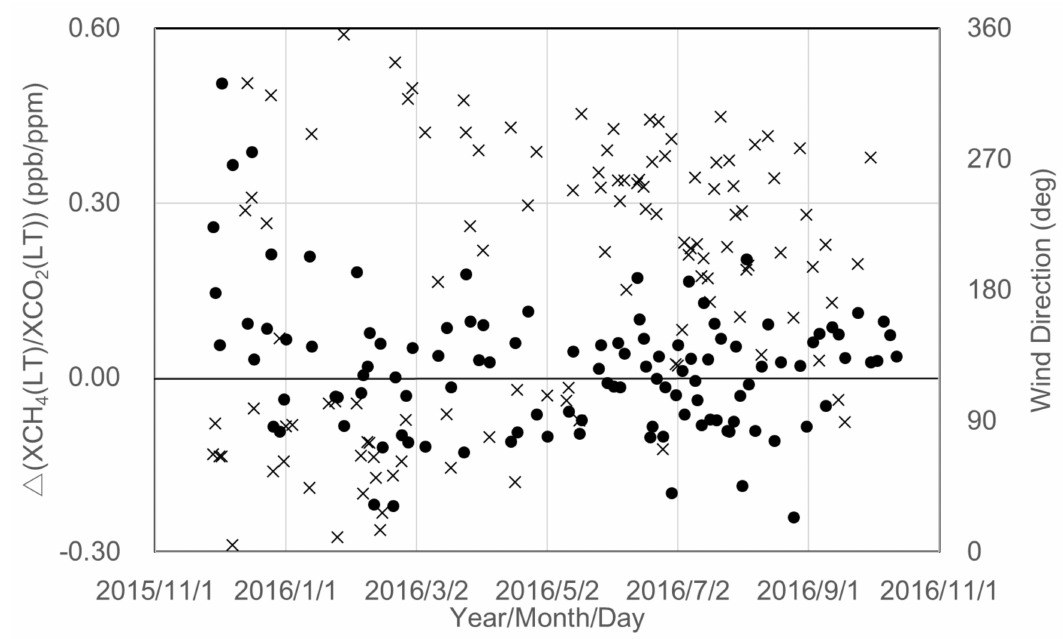
Figure A3. XCH 4 (LT) / XCO 2 (LT) enhancement with time between the blowout and leak control (circles) as well as the WRF wind direction